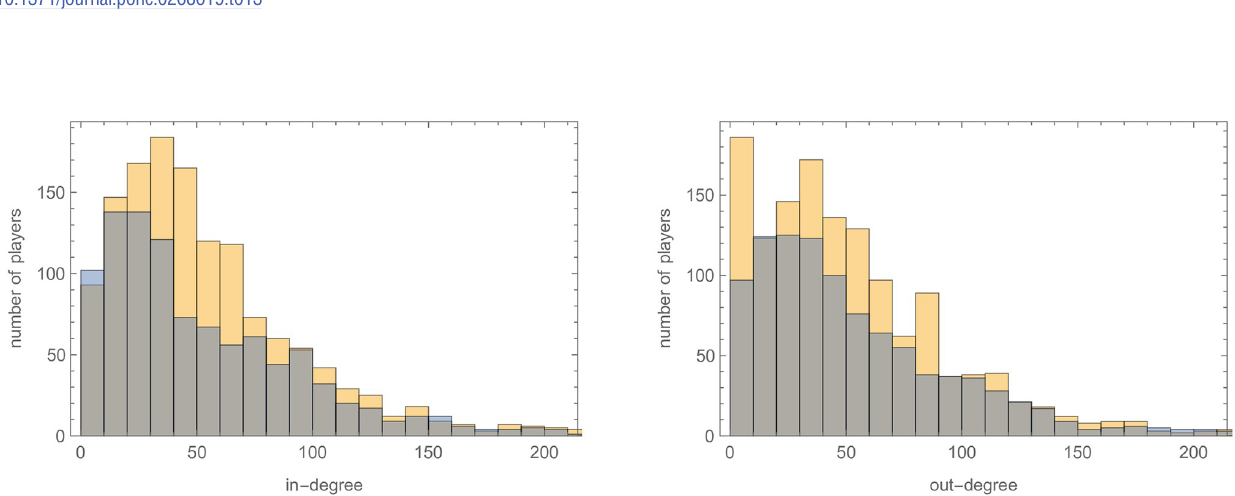
Fig 5. A histogram of the in-degree and out-degree centrality for the baseball and basketball-Twitter networks are shown left and right, respectively. Baseball is shown in orange and basketball is shown in blue in each